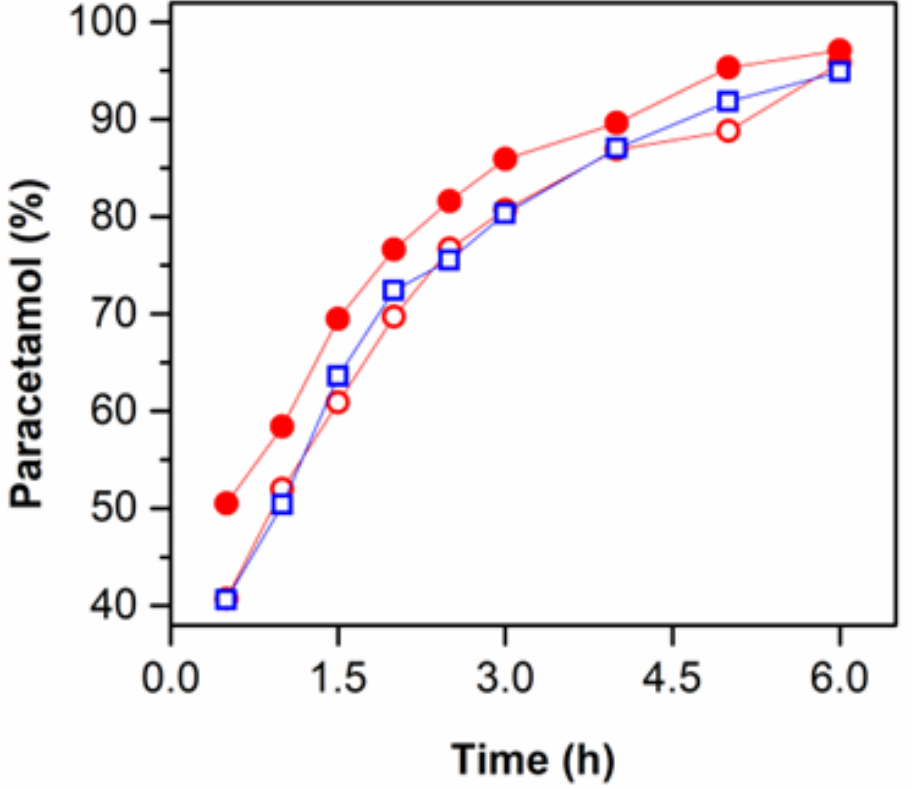
Figure 4. Effect of geometry and hierarchical roughness of polycationic hydrogels onto the sorption capacity of anionic model molecule (methyl orange [0.0625 mM]) at room temperature (~23 °C) ( A ) and illustration of each aqueous media before and after the contact with the samples ( B ). The hy- drogels were coded as: CS-Sph ( ), CS-Sph r ( ) and CS-Cub ( ).